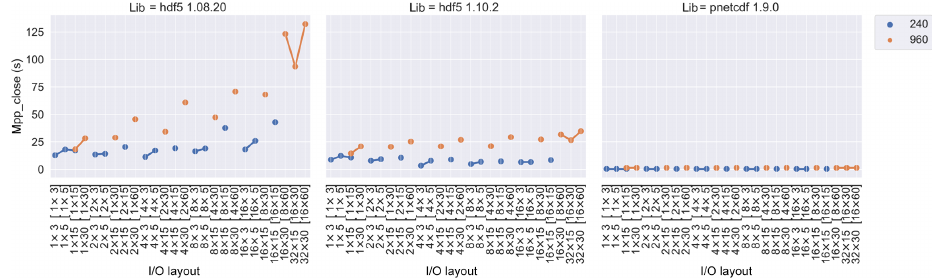
Figure 6. mpp_close time versus I / O layout with different libraries and PE numbers. Contentions within the HDF5 library lead to perfor- mance problems, which increase with layout and number of PEs. PnetCDF does not exhibit these issues, and close times are negligible. The I / O layout together with its PE distribution in [PE per node × nodes] are labelled on the x axis.